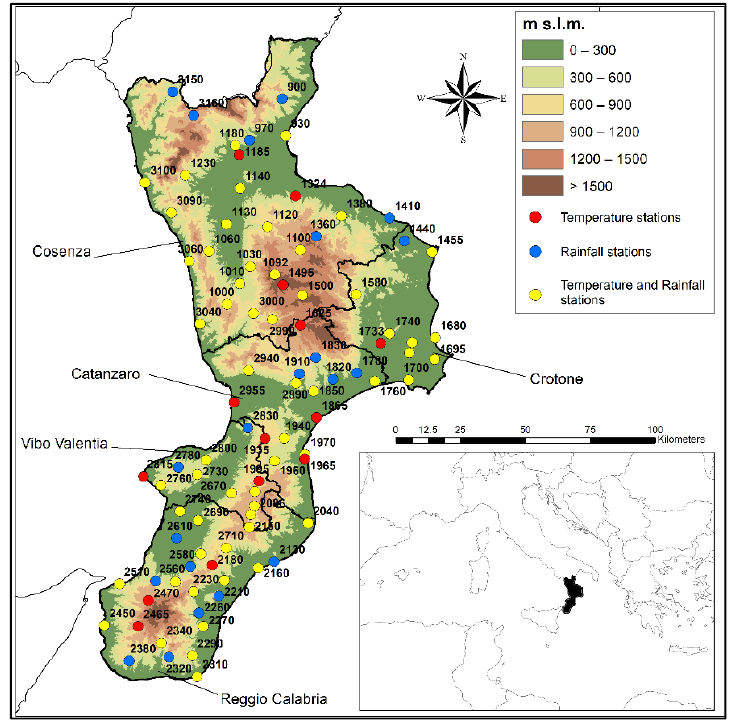
Figure 1. DEM of Calabria with indication of the rainfall and temperature stations. Table 1. Weather stations used in the study, with indication of ID and elevation (m a.s.l.).